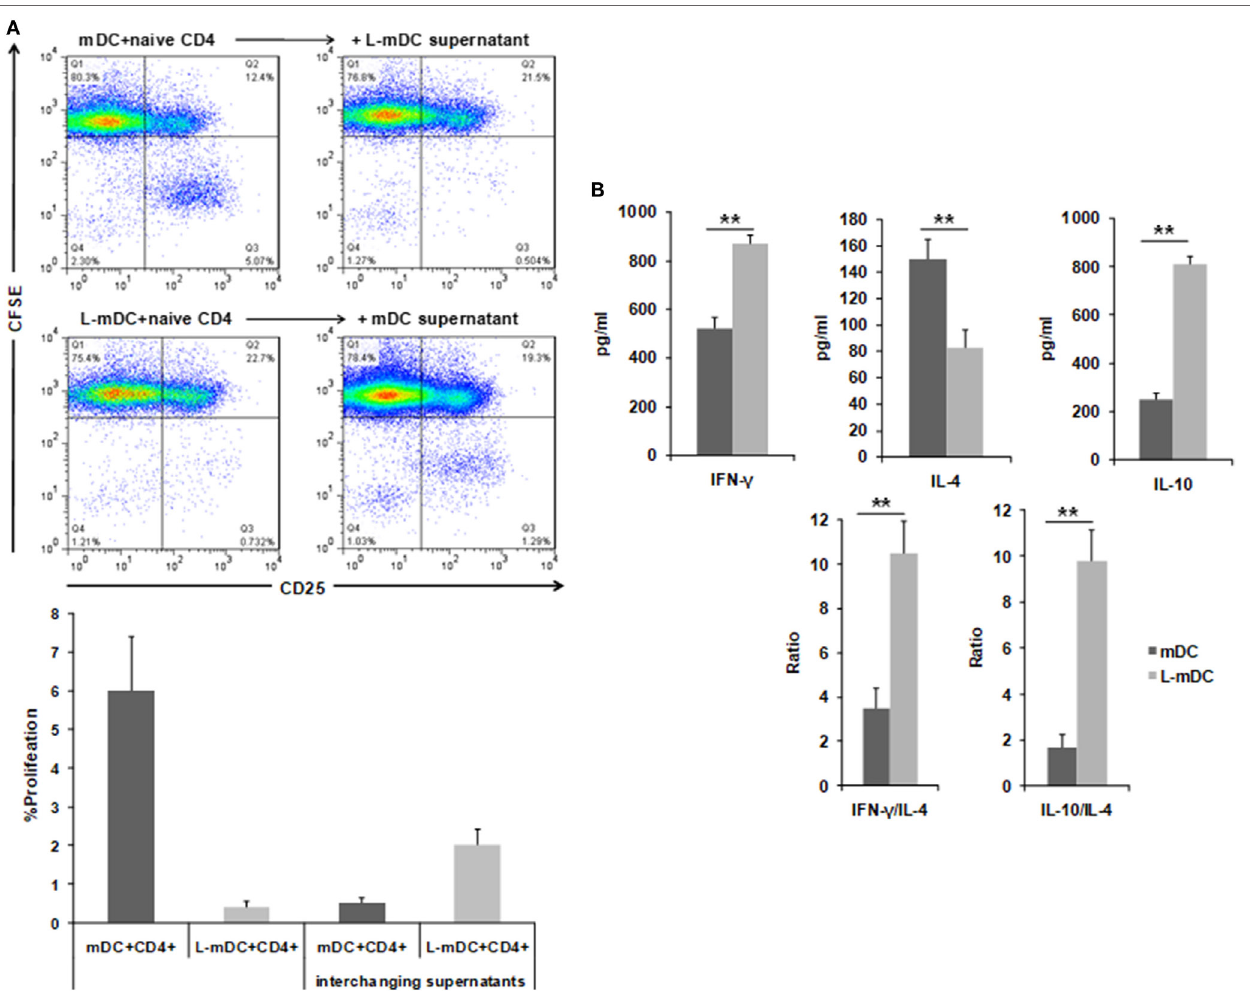
FigUre 7 | L-DCs induce naïve CD4 + T-cell activation and Th1 polarization. Mixed lymphocyte cultures were performed with DCs and allogeneic CD4 + naïve T-cells stained with CFSE. (a) CD3 + CD4 + T-cells were gated after 5 days of co-culture and then CFSE and CD25 expression was analyzed. Upper left panel shows CD4 + T-cell proliferation (CD25 + , CFSE-cells) after being co-cultured with control DCs. The upper right panel shows the same experiment, but was performed by adding supernatants from L-mDCs. Lower left panel shows that all the CD4 + CD25 + T-cells are CFSE + . The lower right panel shows the same experiment, but was performed with supernatants from control mDCs. A representative of four experiments is shown. (B) Th1 vs Th2 cytokine profiles were assessed by enzyme-linked immunosorbent assay quantification of IFN γ , IL-4, and IL-10 in the mixed lymphocyte culture supernatants (** p <